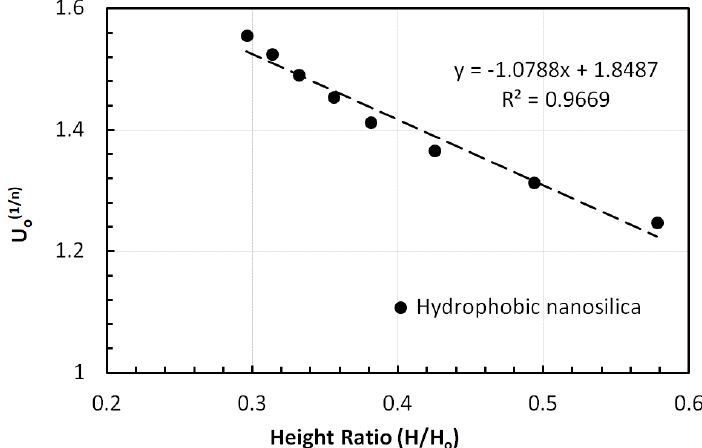
Figure 12. Evaluation of the terminal velocity from the dependence of the bed expansion on the gas velocity.